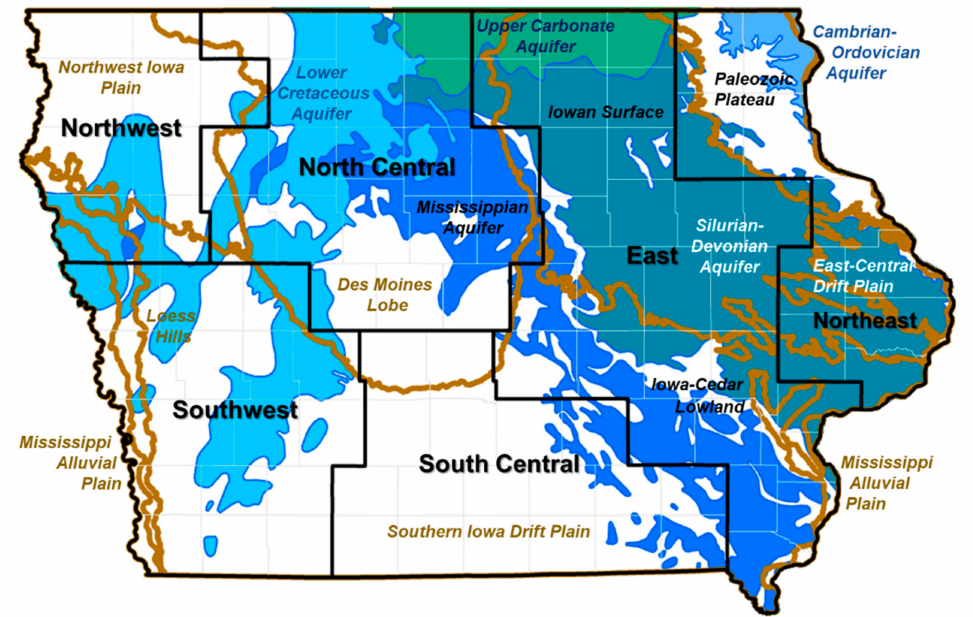
Figure 1. Hydrogeologic regions of the state of Iowa. Iowa was divided into six regions with similar soil type, landscape, and hydrogeologic characteristics as used in Iowa’s state-wide rural well water survey. The bold brown lines on the map represent the boundaries between the regions defined by landforms, and the blue and green colored areas represent the